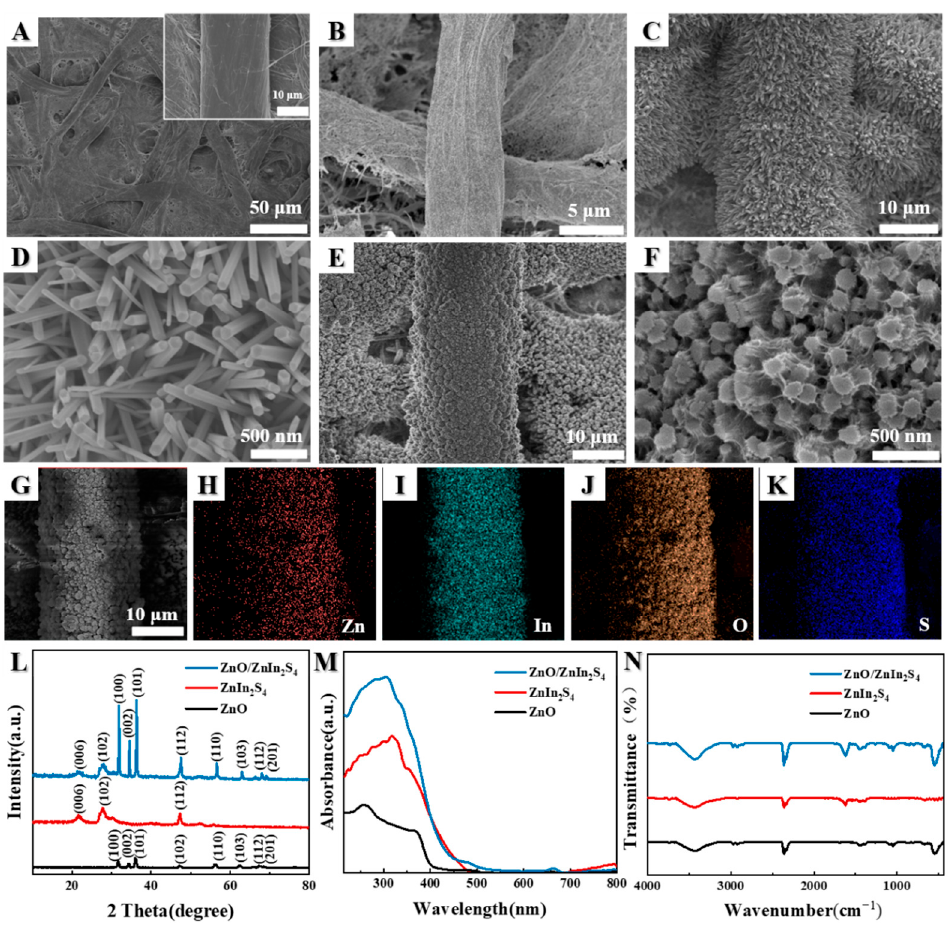
Figure 2. ( A ) SEM images of the bare paper fiber under different magnifications. ( B ) SEM image of Au/paper substrate. ( C , D ) SEM images of paper-based ZnO under different magnifications. ( E , F ) SEM images of paper-based ZnO/ZnIn 2 S 4 under different magnifications. ( G – K ) The SEM-mode elemental mapping images for Zn, In, O, and S. ( L ) XRD of ZnO, ZnIn 2 S 4 and ZnO/ZnIn 2 S 4 . ( M ) UV-vis data reaction system. ( N ) FT-IR spectra of ZnO, ZnIn 2 S 4 , and ZnO/ZnIn 2 S 4